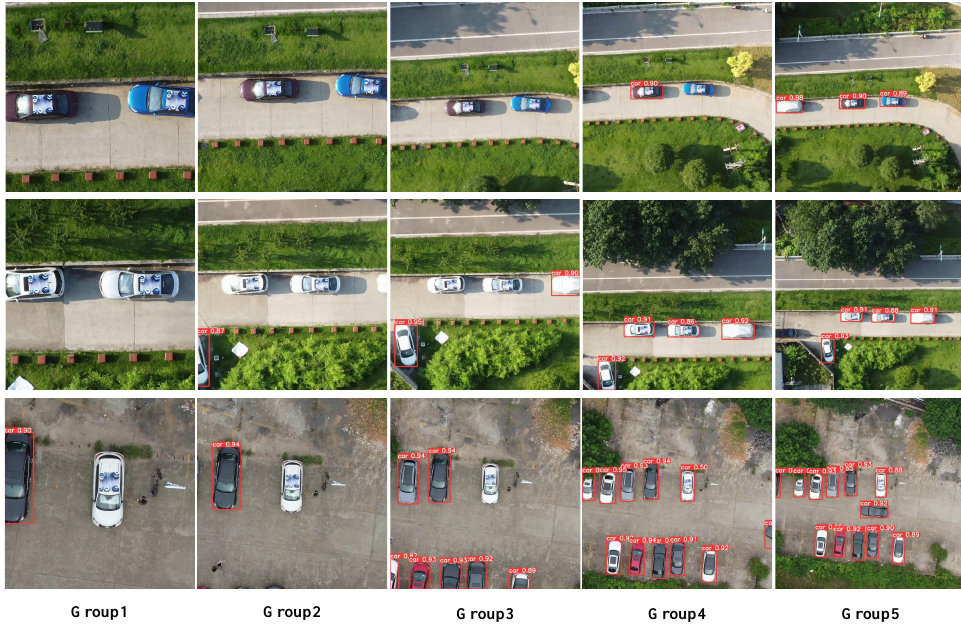
Figure 8. Selected examples of physical attacks on Yolo-V5. These examples are from three scenes, and the images in the same row are from the same scene. For every scene, we select five images from five